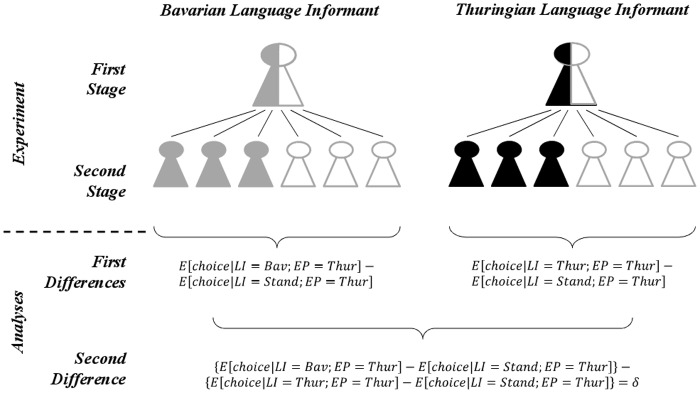
Regional intensity across the language samples.The figure shows the regional intensity of our language samples relative to codified standard German (d = 0). We find a strong and comparable deviation of both regional language samples from codified standard. At the same time, we find an insignificant difference between these two regional accent samples and between the two standard accent samples.